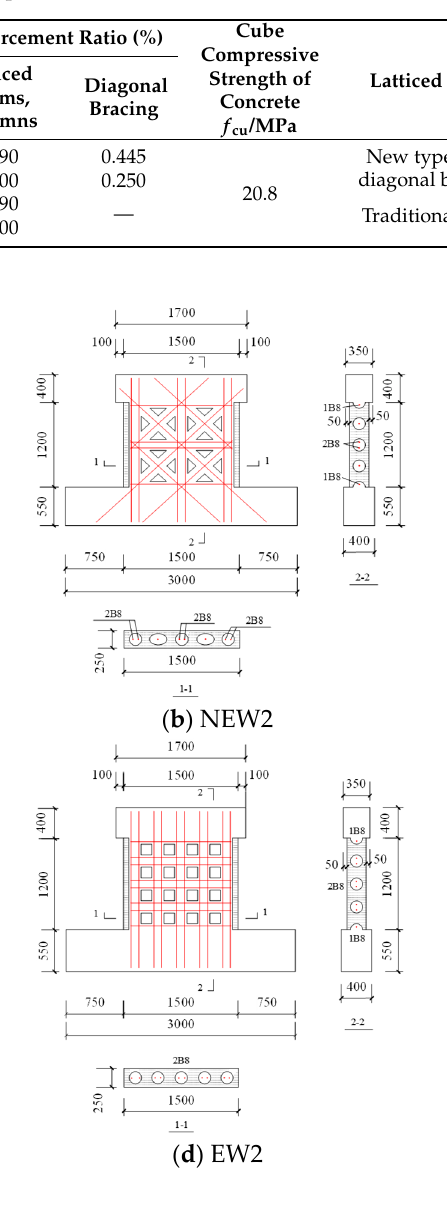
Table 2. The main parameters of the specimens.